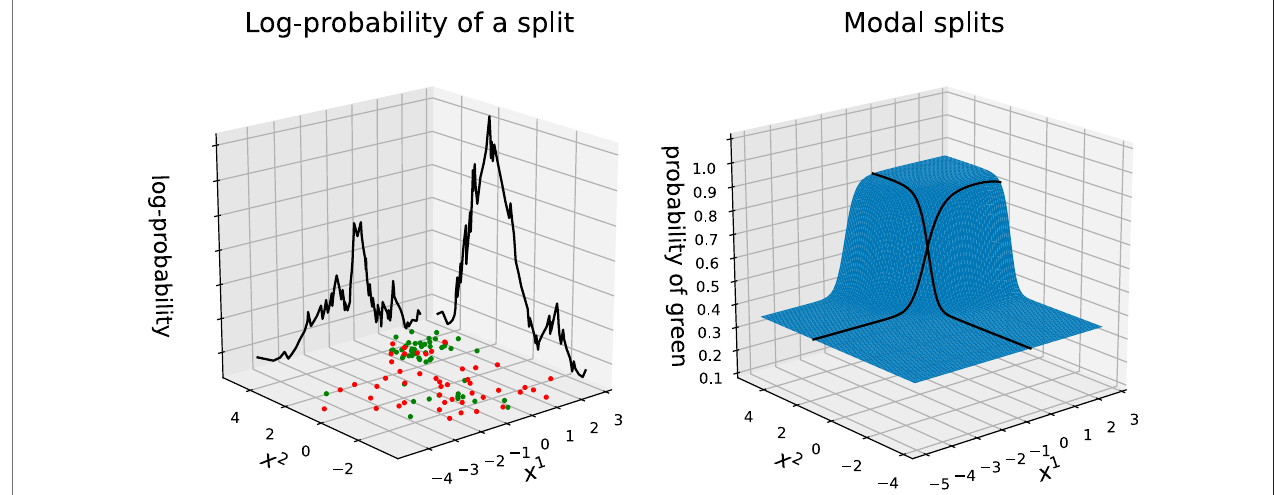
FIGURE 2 | Example of a data set whose outcomes are either green or red. The location ofthe points is sampled from a mixture oftwo Gaussian distributions with equal probability. One distribution draws outcomes from a Bernoulli distribution with probability 0.25, while the other from a Bernoulli with probability 0.75. On the left: log-probabilities of all possible non-trivial partitions given the data set. On the right: actual probability of a point being green and modal splits along each dimension.